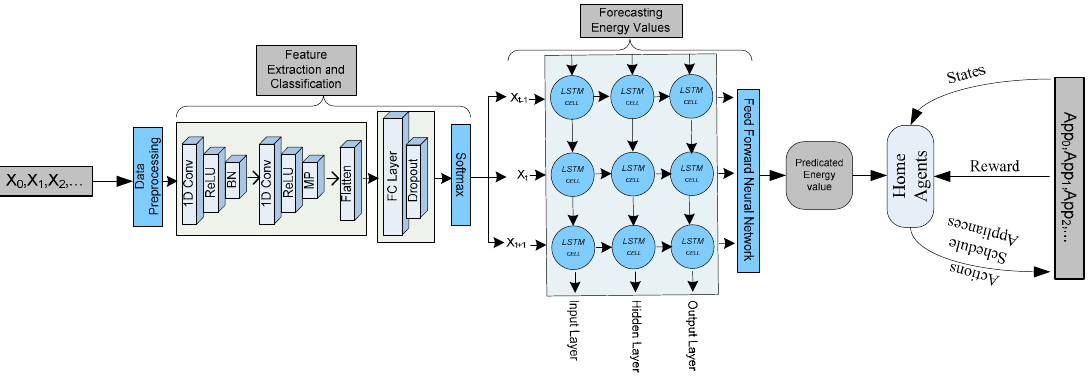
Figure 2. The architecture of the proposed scheme.